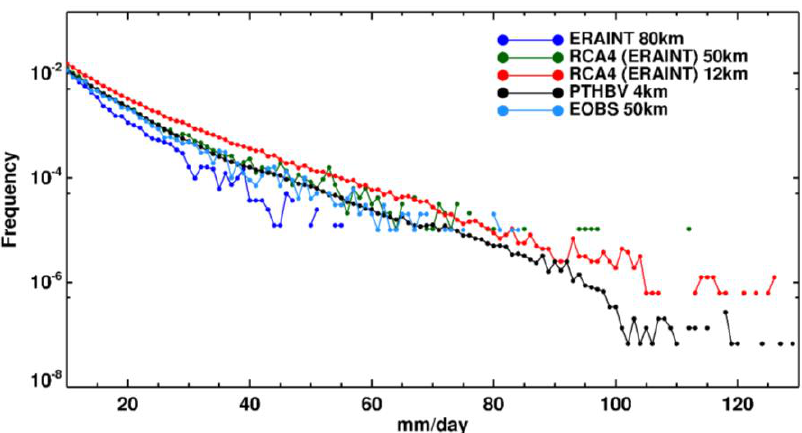
Figure 2. Frequency–intensity (FI) distribution of daily precipitation > 10 mm/day over southern Sweden (12°E–17°E, 55°N –60°N, only land) in summer (June–August) for observation (E-OBS and PTHBV), Era-Interim reanalysis, and regional SMHI-RCA4 simulations at 12 and 50 km resolution driven by ERA-Interim. For each dataset all grid boxes and days are pooled into one sample to estimate the FI distribution.